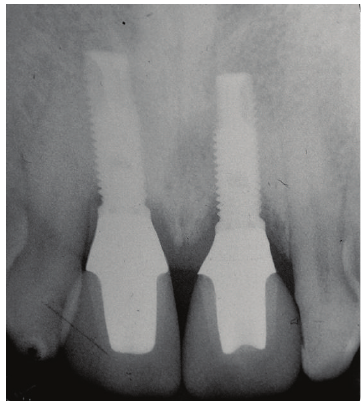
Figure 8: Periapical radiograph after 5 years which showed osseoin- tegration of the implants with only a minimal loss of bone height according to the Albrektsson